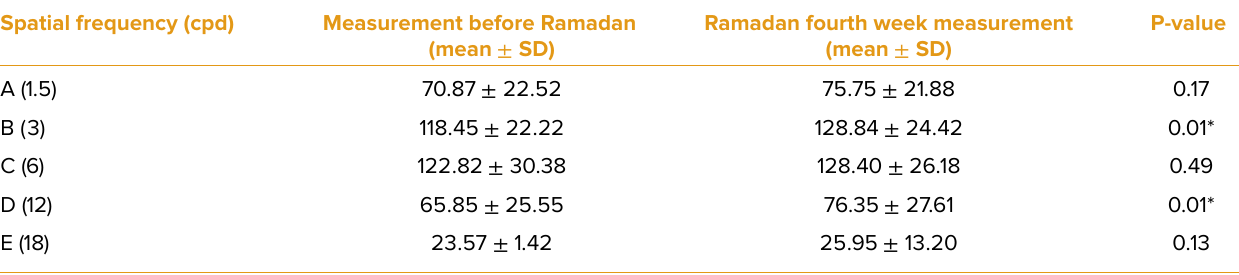
Table 3. The comparison of contrast sensitivity measurements conducted before the Ramadan and at the fourth week of Ramadan Spatial frequency (cpd)